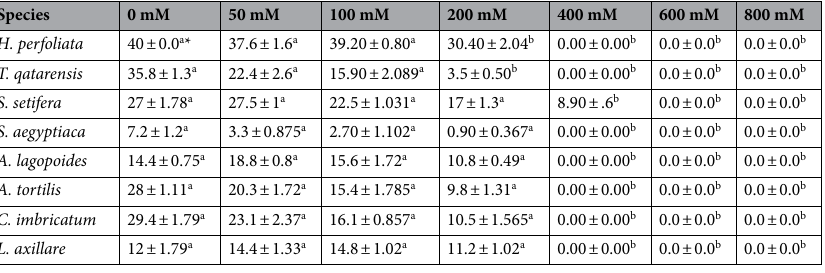
Table 3. Germination indices of eight halophyte species at different NaCl concentrations. *Values are means ± SE (n = 5). Means in a row sharing the same 1etter are not significantly different according to Tukey’s test at p ≤